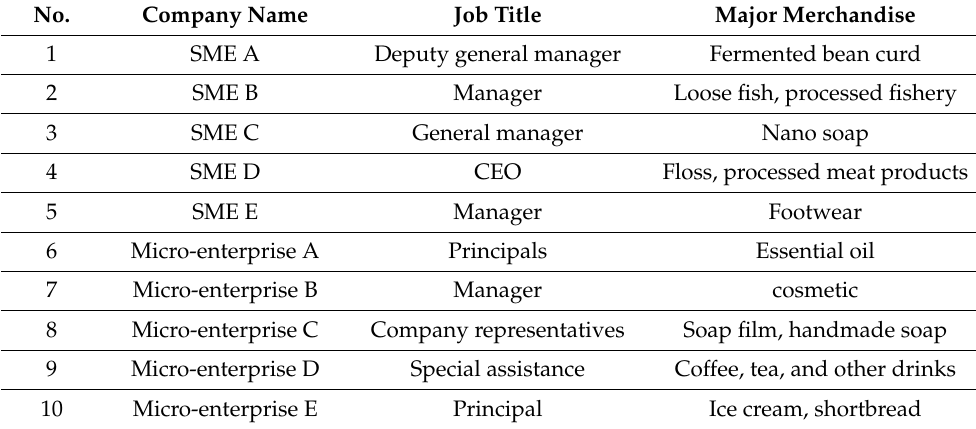
Table 2. Interviewee